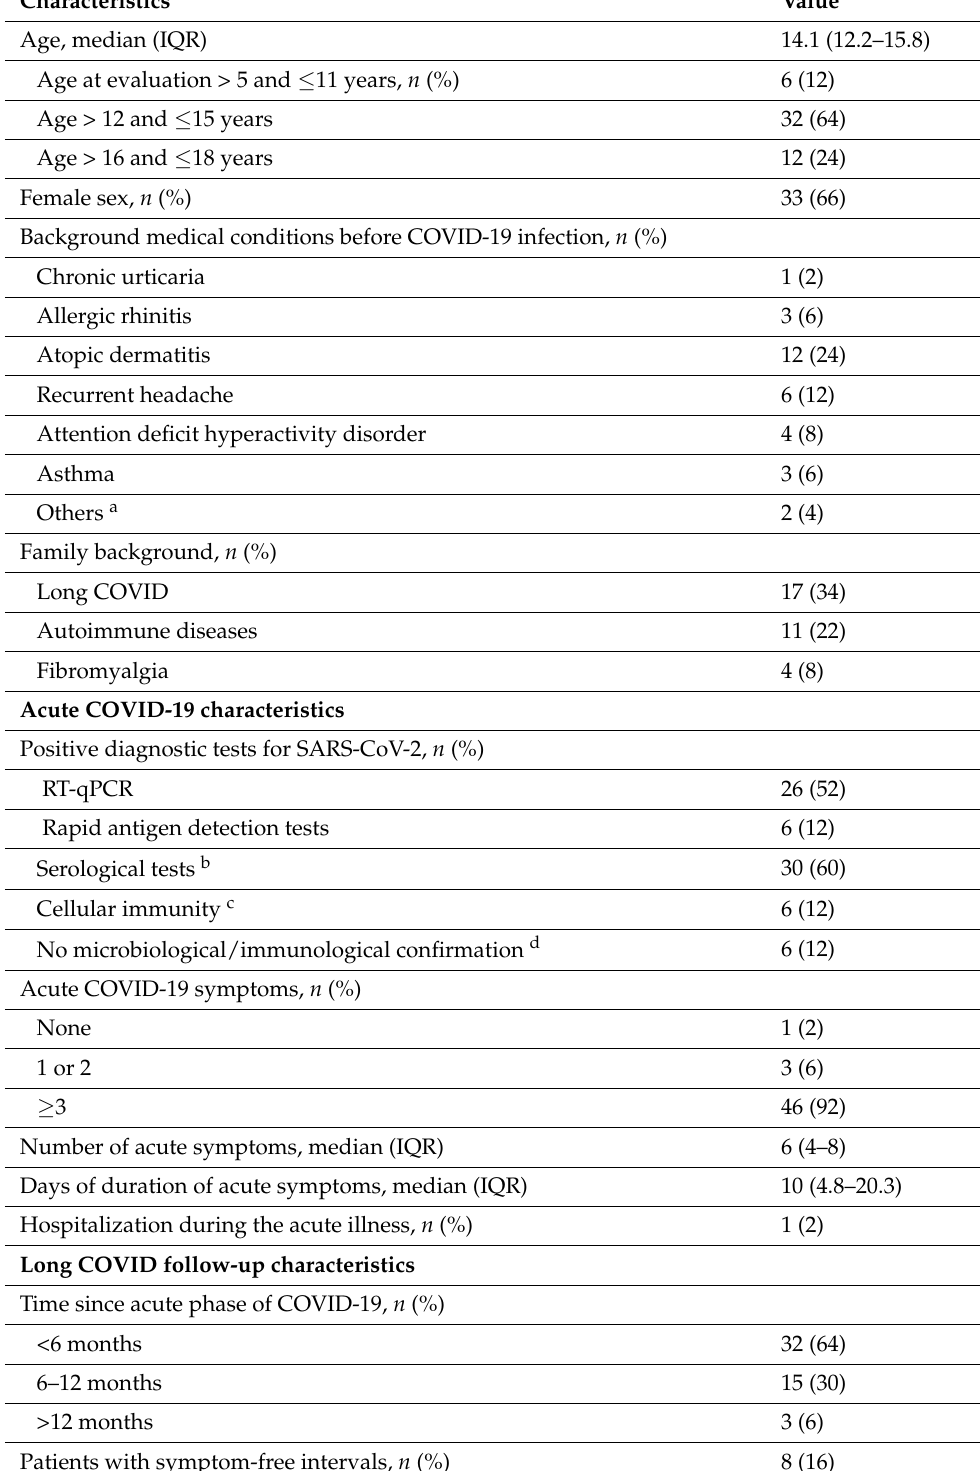
Table 1. Demographic and clinical characteristics of the study sample. Effect of long COVID on the physical activity, mental health, and academic performance of pediatric patients ( n =